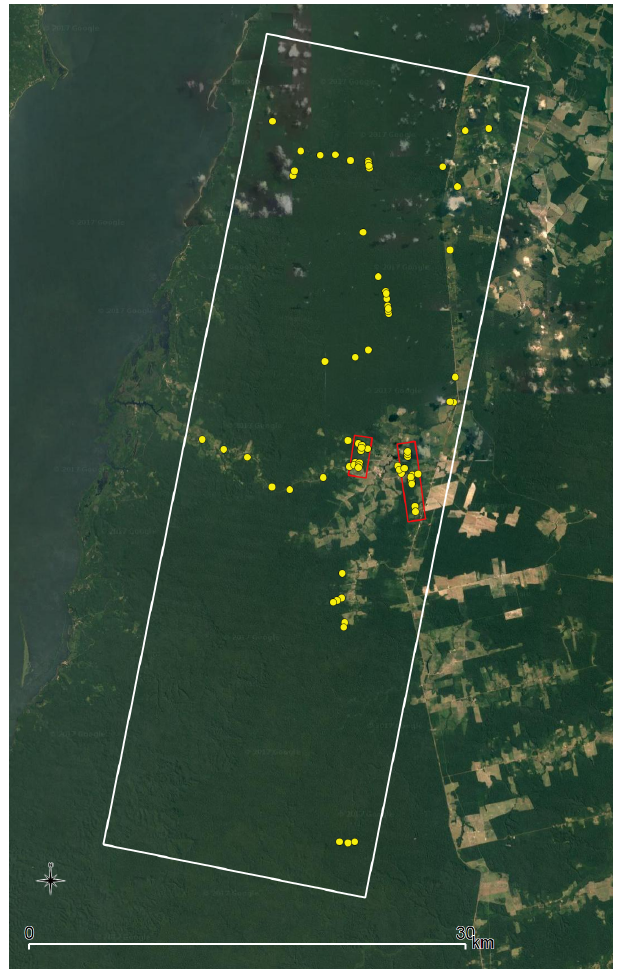
Figure 1. The Tapajós National Forest covered by TanDEM-X (large white rectangle) in this study. Yellow dots are 78 field plots, and the smaller red rectangles are areas of LiDAR